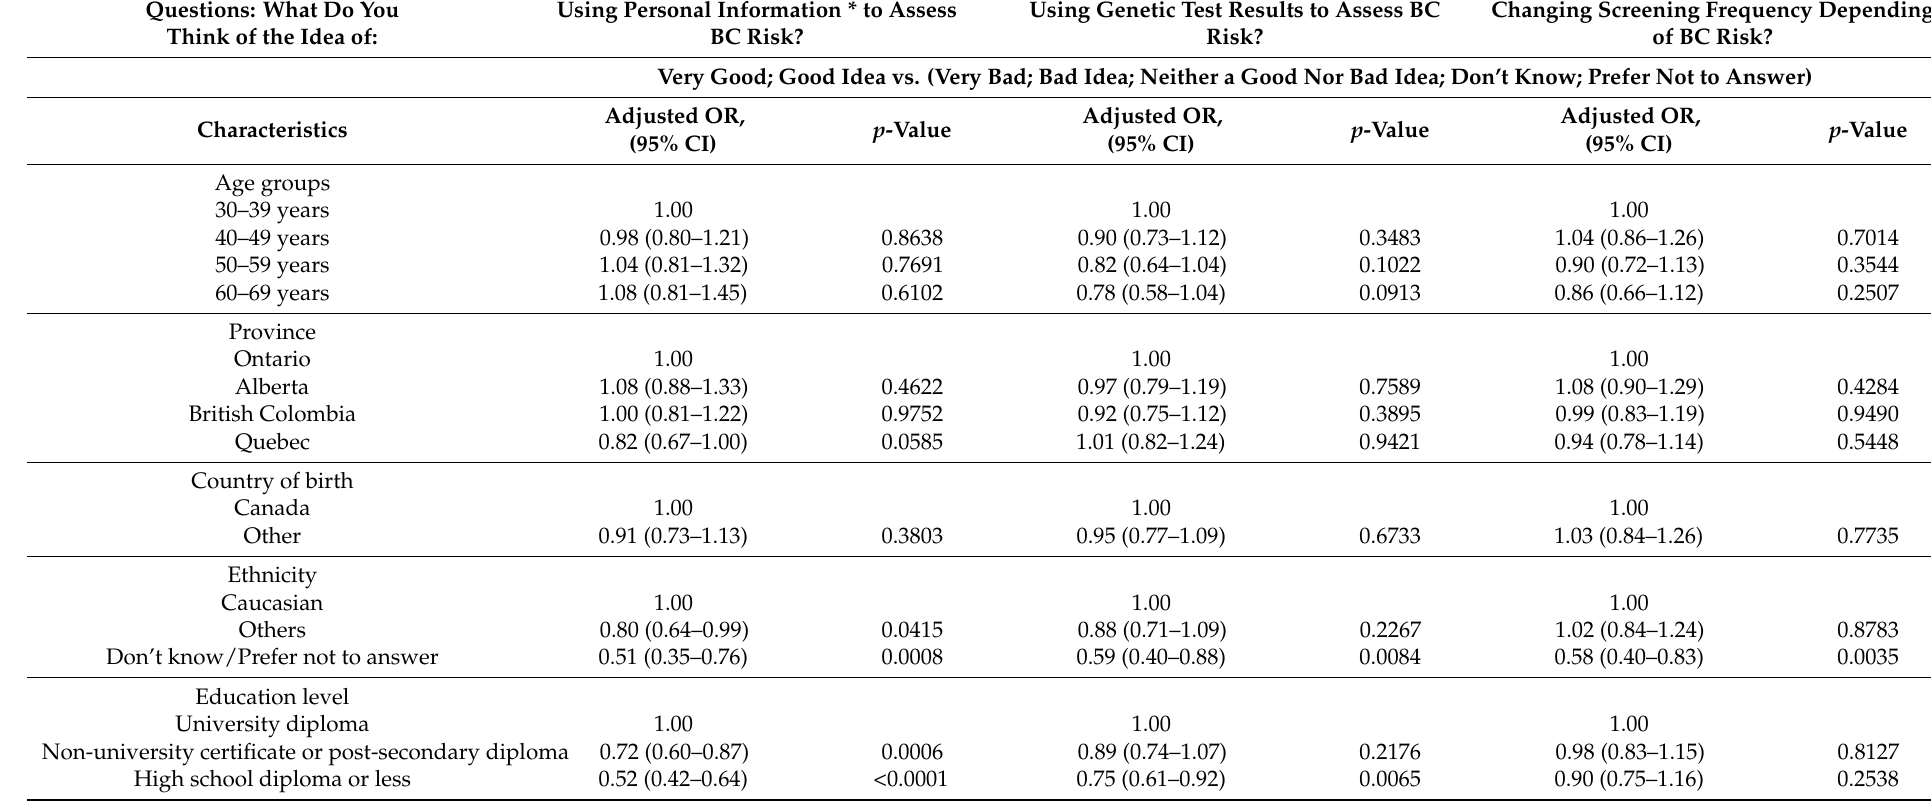
Table 2. Mutually adjusted logistic regression models for the associations between attitudes towards breast cancer risk assessment and risk-stratified screening with participants’ characteristics ( n =